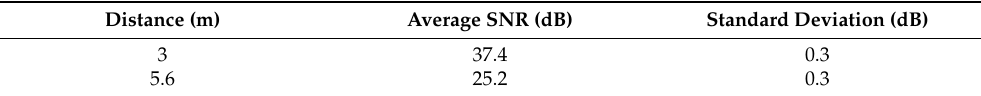
Figure 10. Acoustic signal amplitudes along the buried MDPE pipe at ( a ) 3 m and ( b ) 5.6 m. Table 5. Measured acoustic SNR along the buried MDPE pipe. Table 5. Measured acoustic SNR along the buried MDPE pipe.